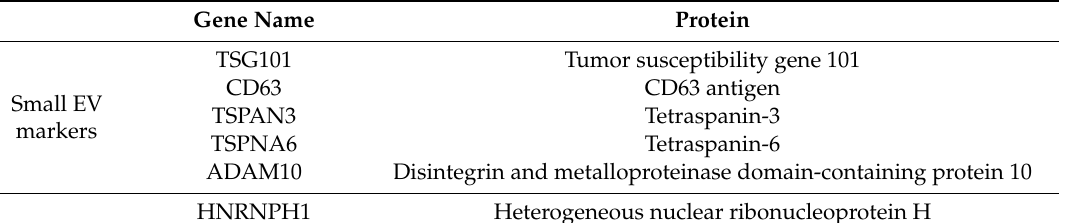
Table 1. List of well-documented markers for exosomes and